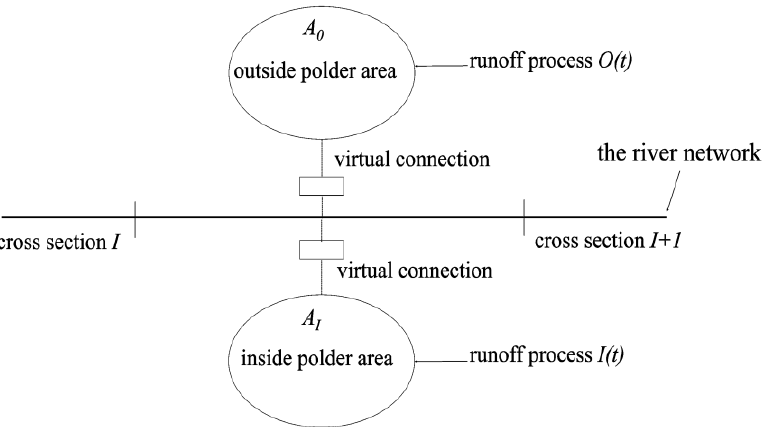
Figure 5. The regulation relationship between outside and inside polder area.